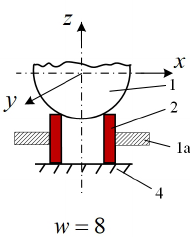
Figure 2. The schematic of the piezoelectric actuator with three active kinematic